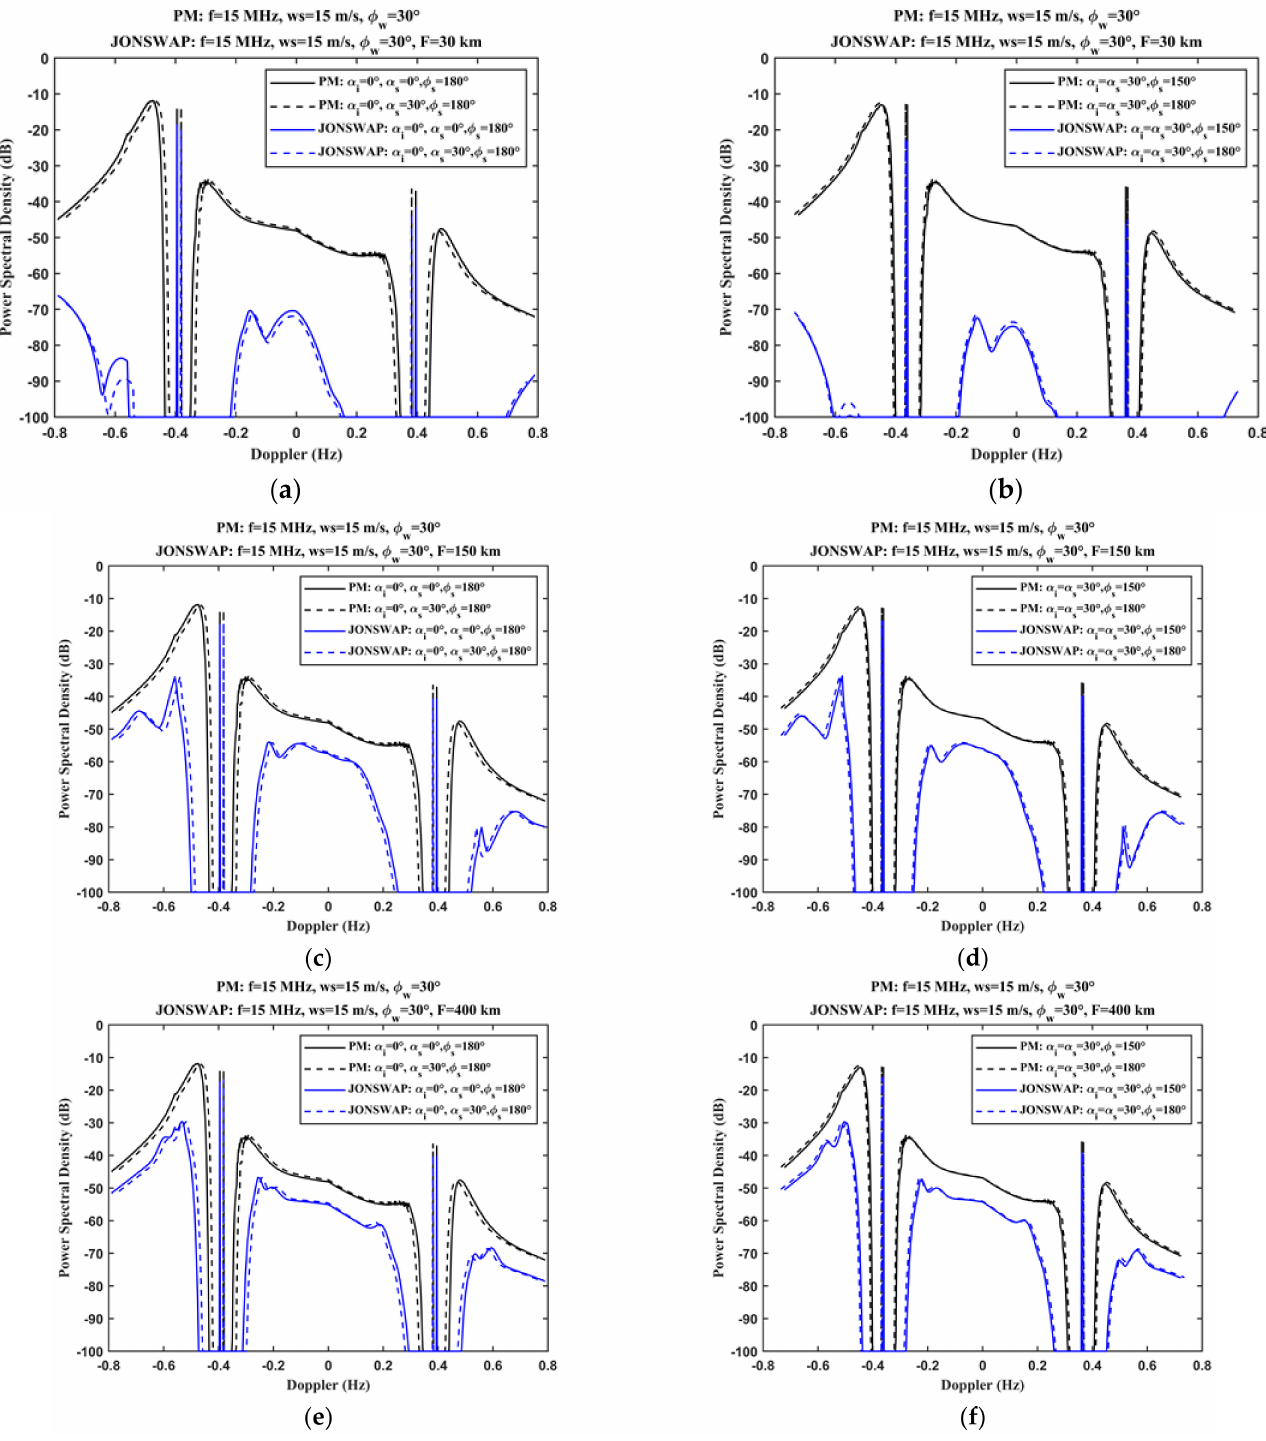
Figure 5. SWR scattering cross-sections under different grazing incidence angle, scattering angle, scattering azimuth angle, and fetch length conditions. The scattering conditions are indicated in each